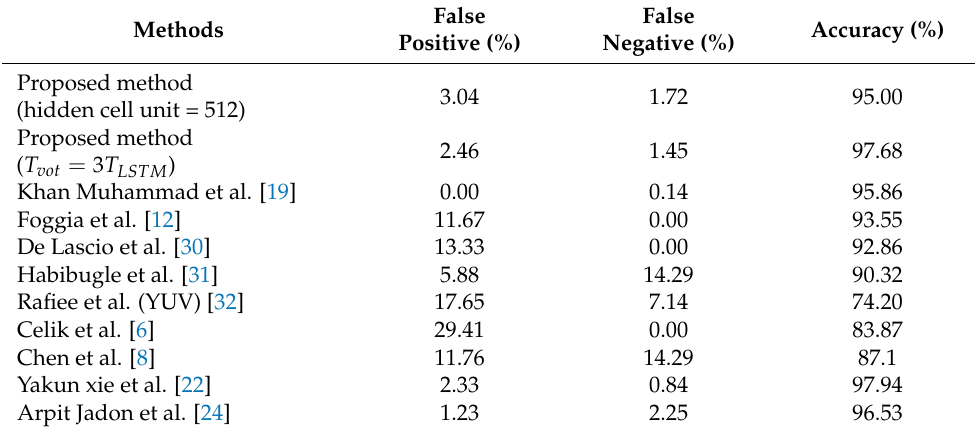
Table 8. Performance comparison with other methods